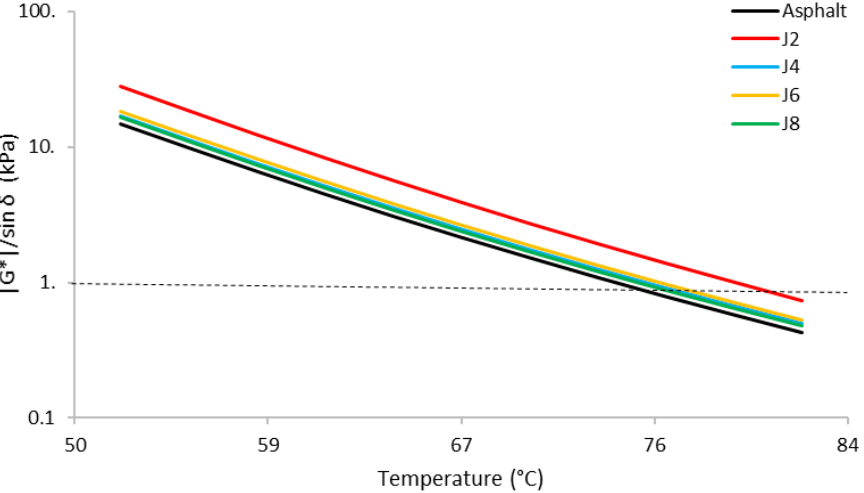
Figure 3. Isochronal plots of |G*|/sin δ vs. temperature of asphalt binder modified by Jatropha curcas seed shell particles.